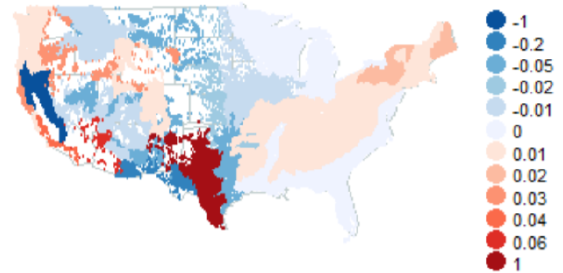
Figure 5. Bayesian basal area growth rates ( ˆ g ) diagram.